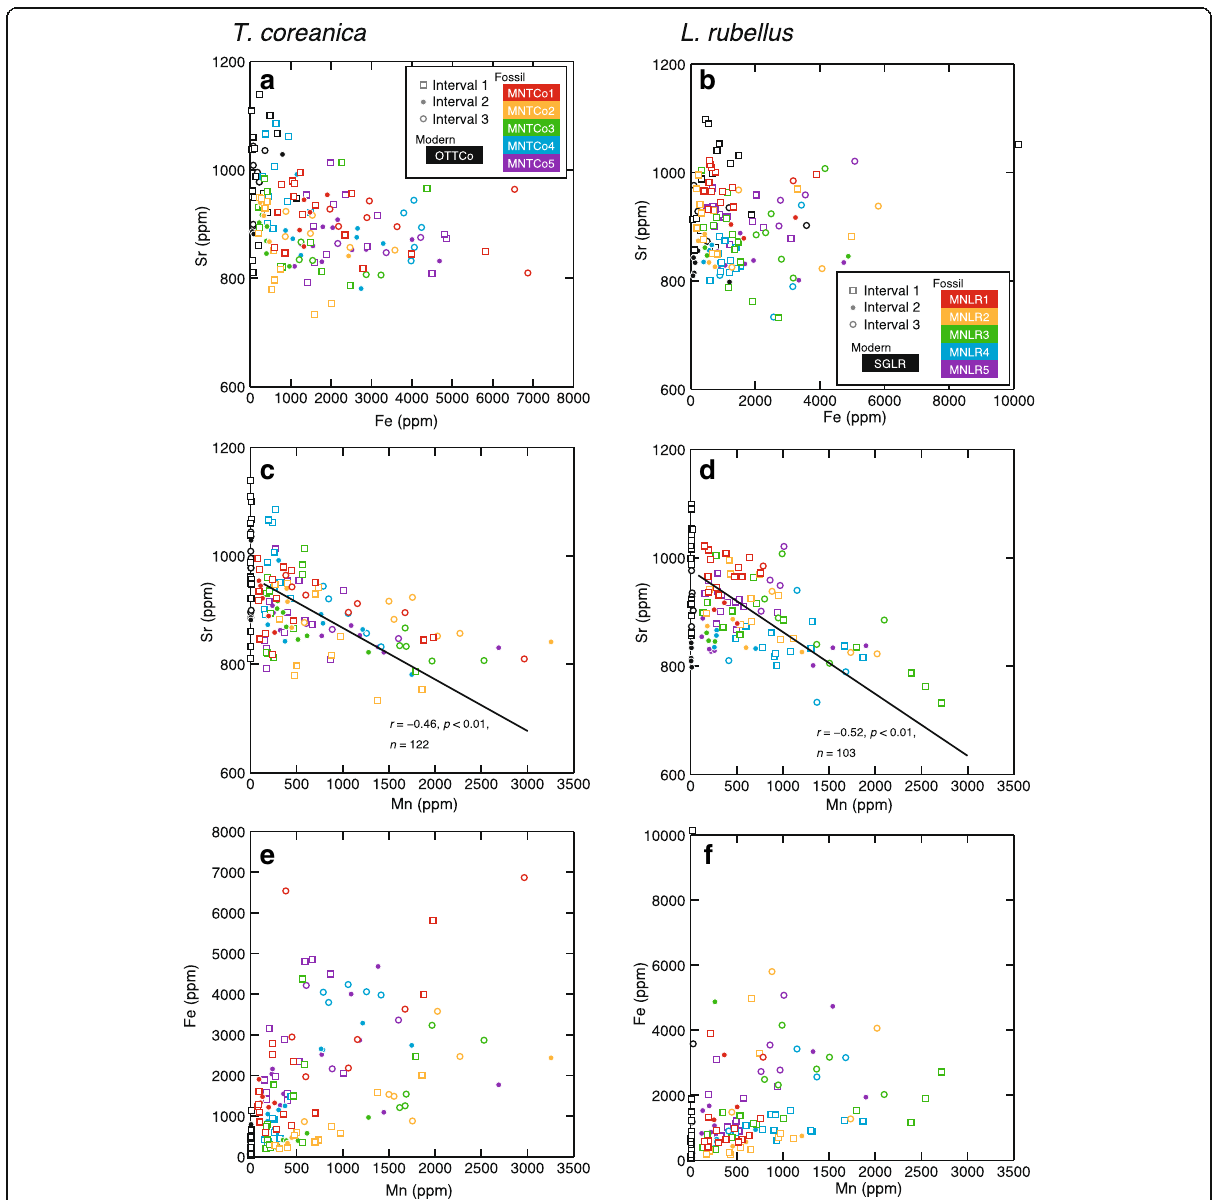
Fig. 8 Cross-plots of minor element (Mn, Fe, and Sr) concentrations in the studied brachiopod shells. The samples were extracted from the modern and fossil T. coreanica ( a , c , e ) and L. rubellus ( b , d , f )